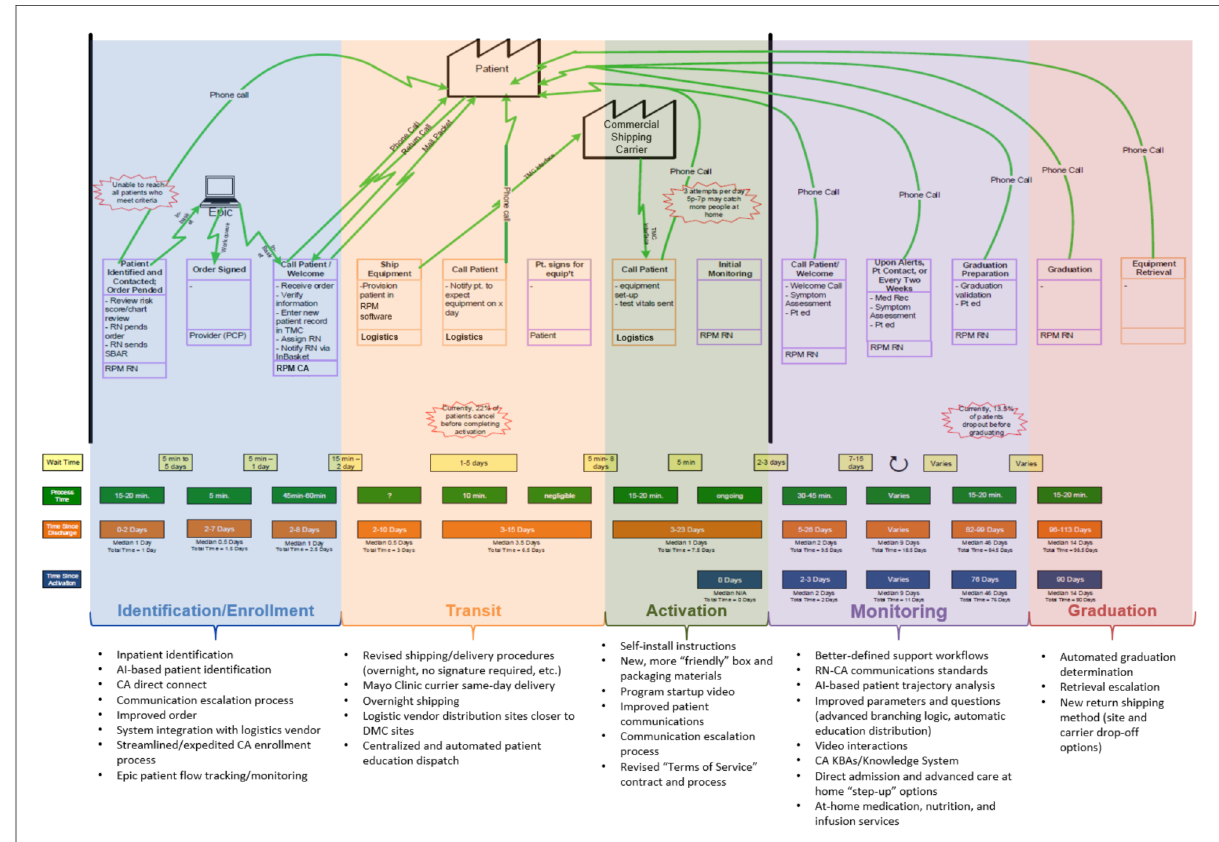
FIGURE 5 RPM program value stream map and quality improvement projects undertaken to improve ef fi